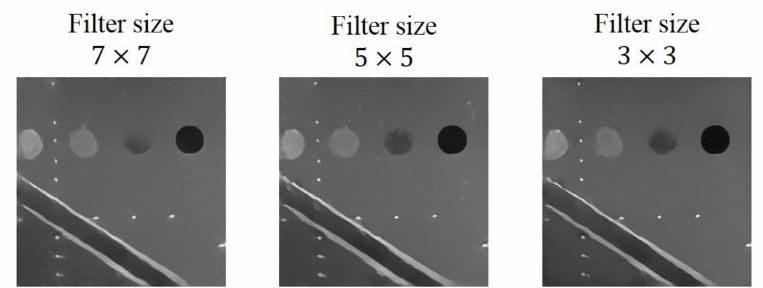
Figure 7. Reconstructed echogenicity maps of the mixed loss model with di ff erent filter size.